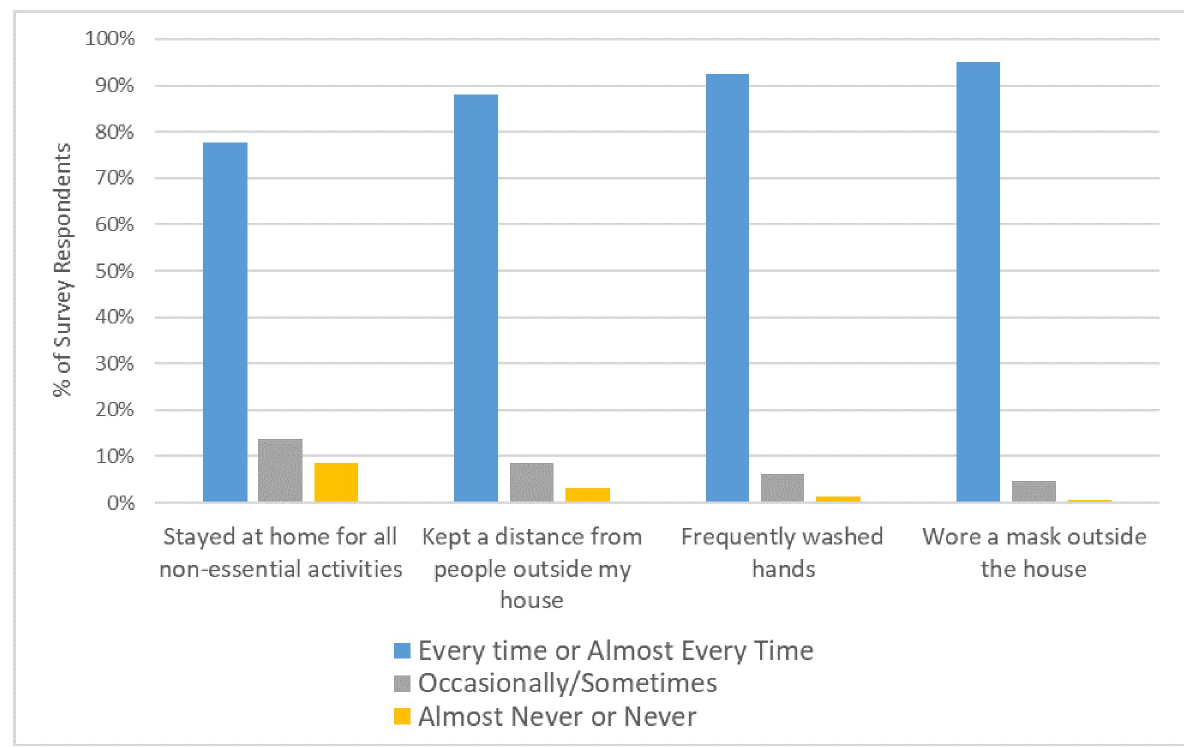
Fig 1. Frequency of COVID-19 prevention behaviors by survey participants in the month prior to survey participation, 2021 (N = 437).